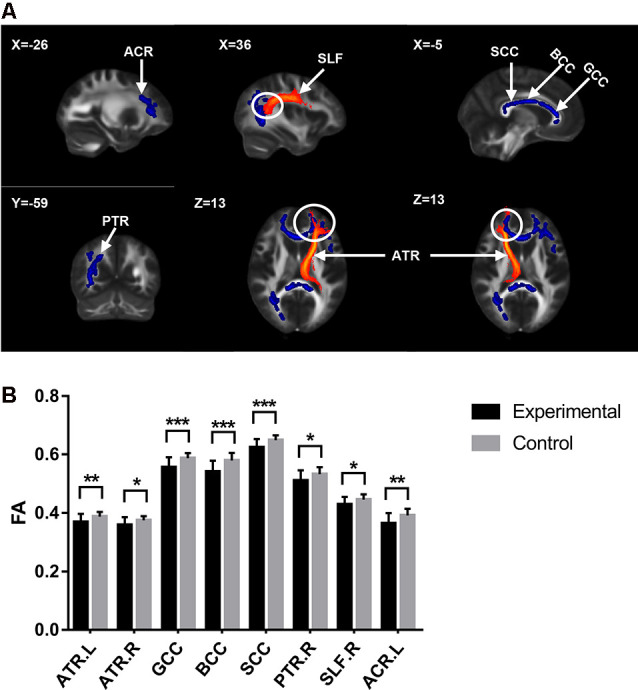
Diffusion tensor imaging (DTI) results with significant difference between groups. (A) White matter tracts with significant fractional anisotropy (FA) values change between groups. The upper left number represents the MNI coordinate slice position. Warm tone (red) represents white matter tracts reference system, while cold tone (blue) represents white matter tracts with significant FA values changes between groups. (B) The comparison of FA values of white matter tracts with significant differences between groups. Experimental = patients. Control = healty control. *p < 0.05; **p < 0.01; ***p < 0.001.